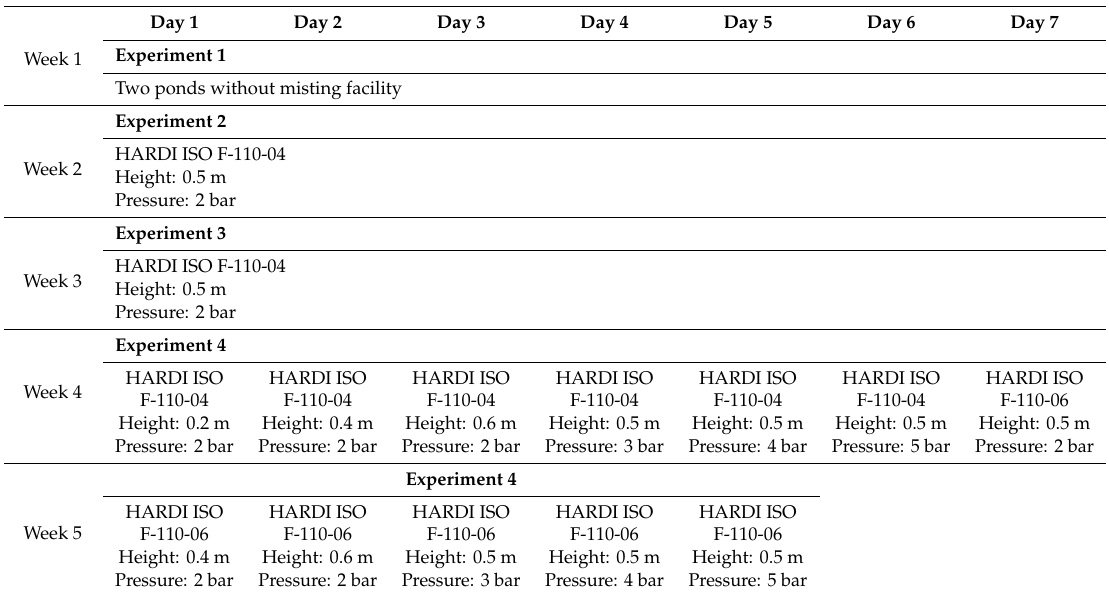
Table 1. Experimental